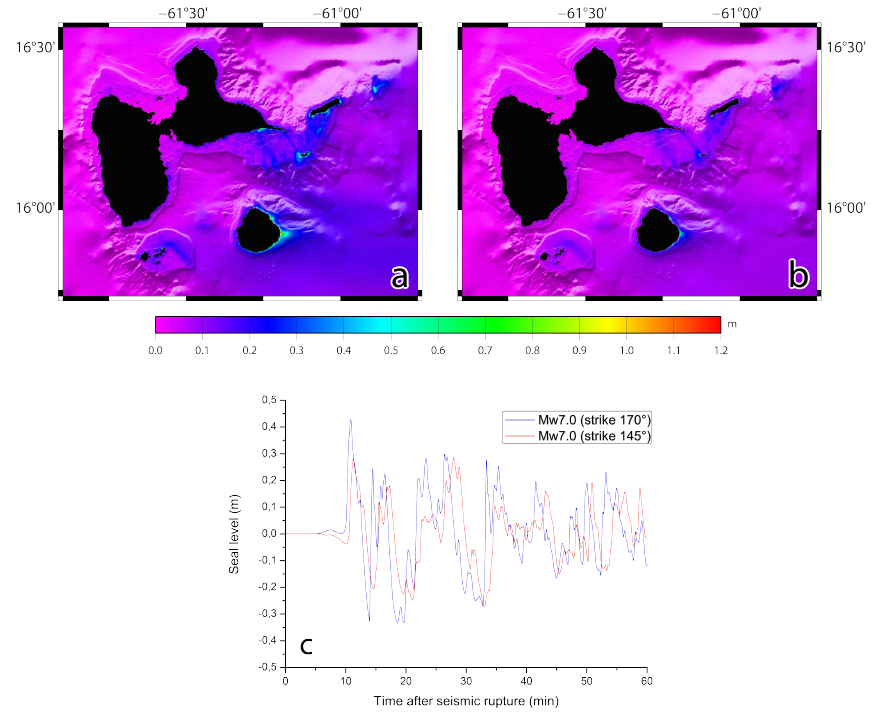
Fig. 12. (a) Maximum wave heights illuminated by a bathymetric gradient obtained for Grid 2 after one hour of tsunami propagation triggered by a magnitude Mw=7.0 earthquake varying the strike angle of the coseismic rupture plan. It corresponds to a strike angle of (a) 170 ◦ and (b) 145 ◦ . Synthetic tide gage records at the Marina entrance in both cases are presented in (c)